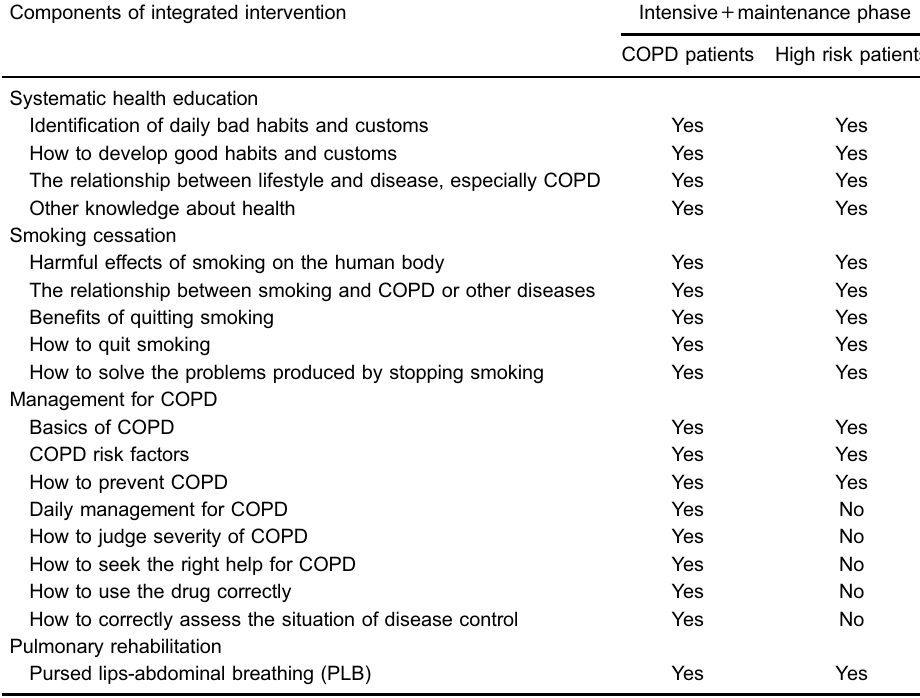
Table 1. Components of integrated